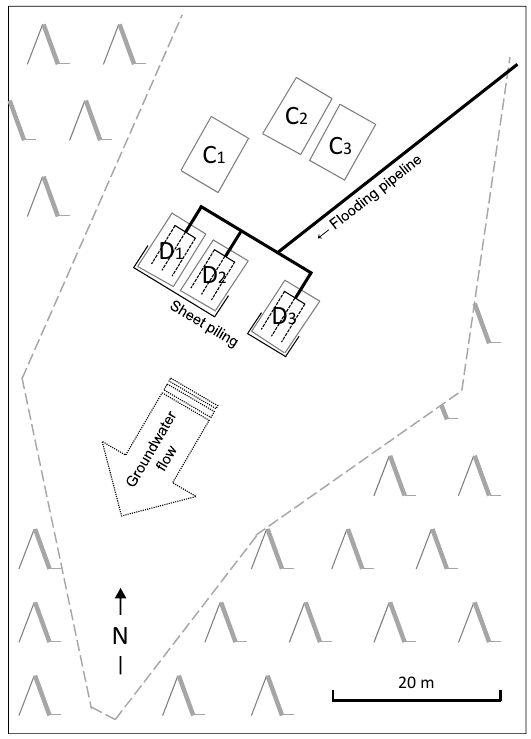
Fig. 1. Schematic illustration of the study site showing control (C1–C3) and flooded plots (D1–D3) and installations made for flooding.